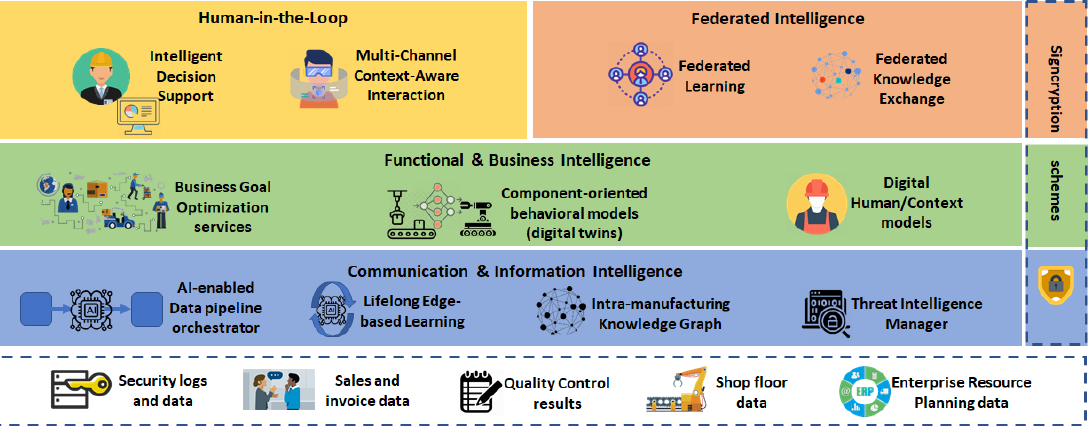
Figure 2. A high-level view of the proposed architecture.